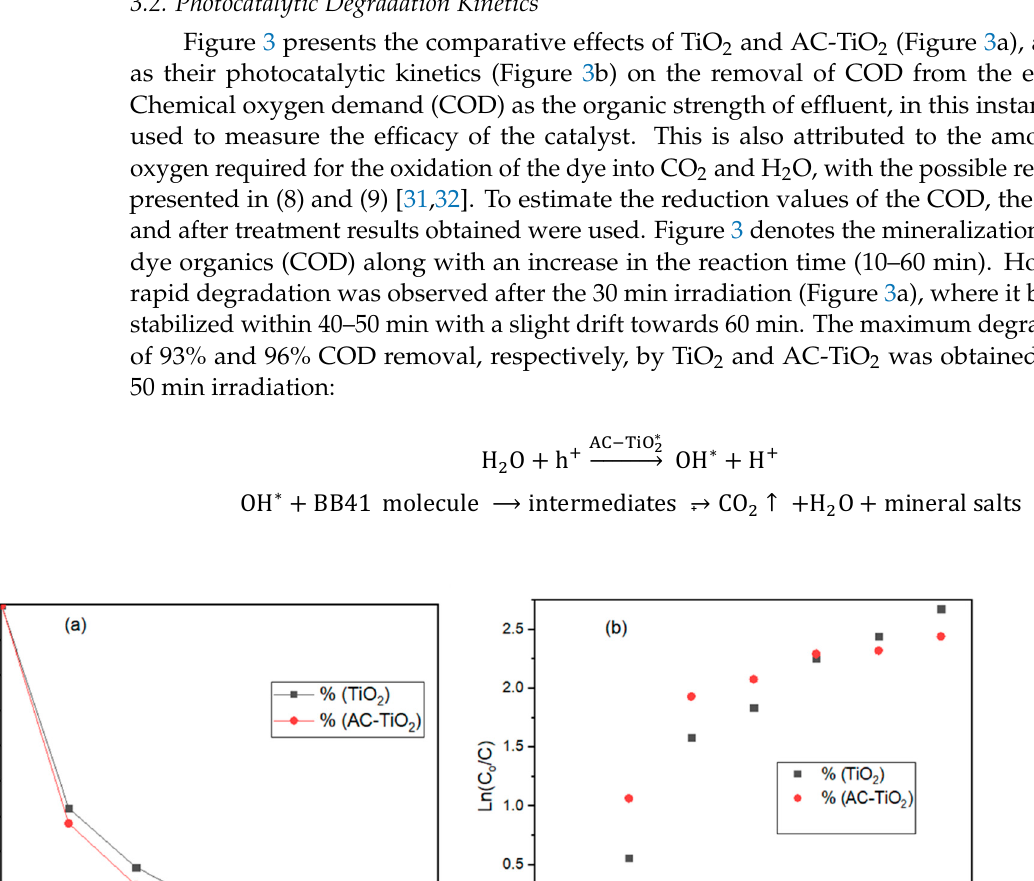
Figure 2. Spectra of ( a ) XRD and ( b ) FTIR analysis for TiO 2 (black) and AC-TiO 2 (red); ( c ) SEM and ( d ) EDX image of AC- TiO 2 and ( e ) EDX spectra and elemental composition of AC-TiO 2.